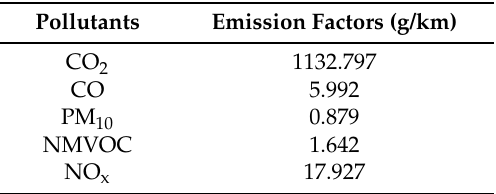
Table 5. Emission factors used for public transport in Province of Trapani